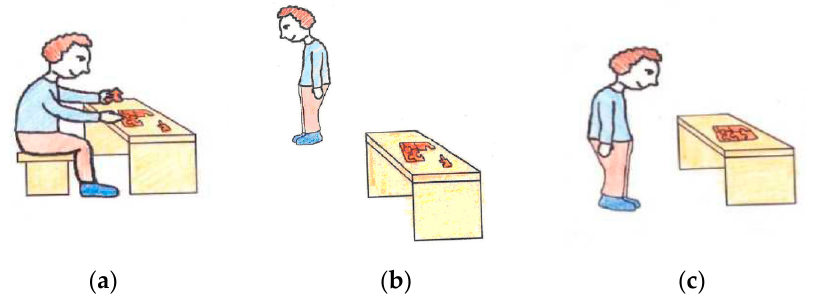
Figure 2. Pictures representing three possible stages of a situation: ( a ) ongoing; ( b ) incomplete and ( c ) complete situation.